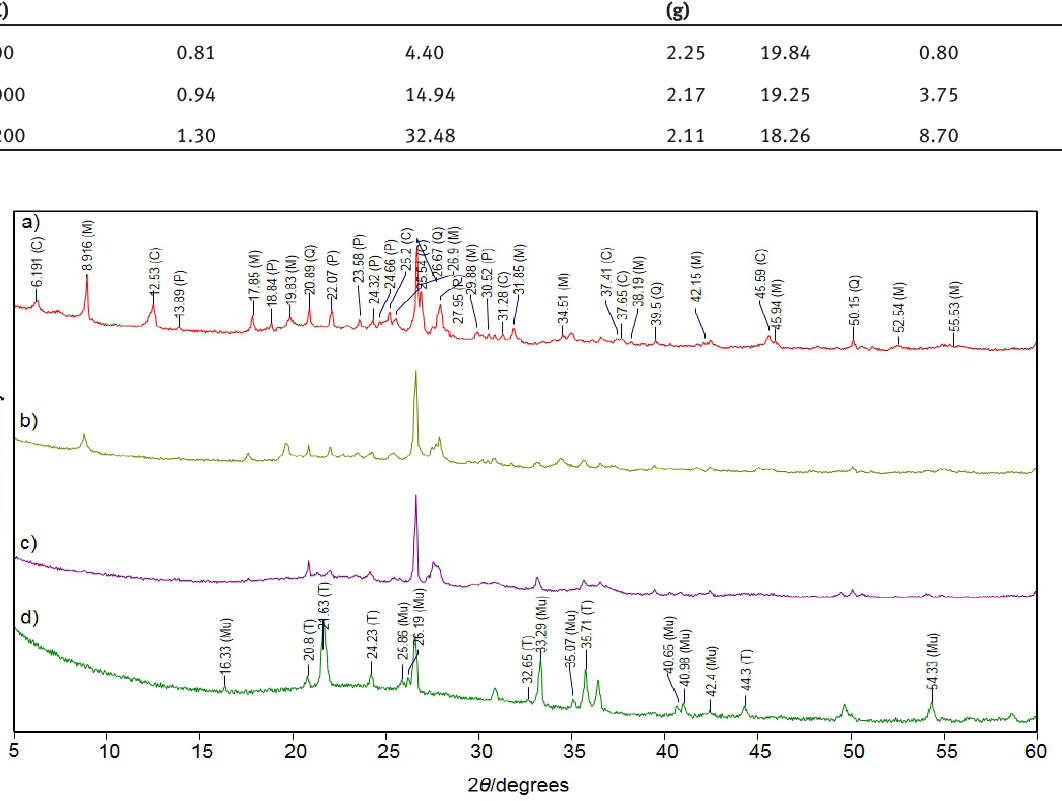
Figure 7: XRPD analysis of raw trepel (a), and thermally treated sample for a period of 1 hour at 800˚C for a period of 1 hour, (b) at 1000˚C for a period of 1 hour, (c) and at 1200˚C for a period of 1 hour (d).